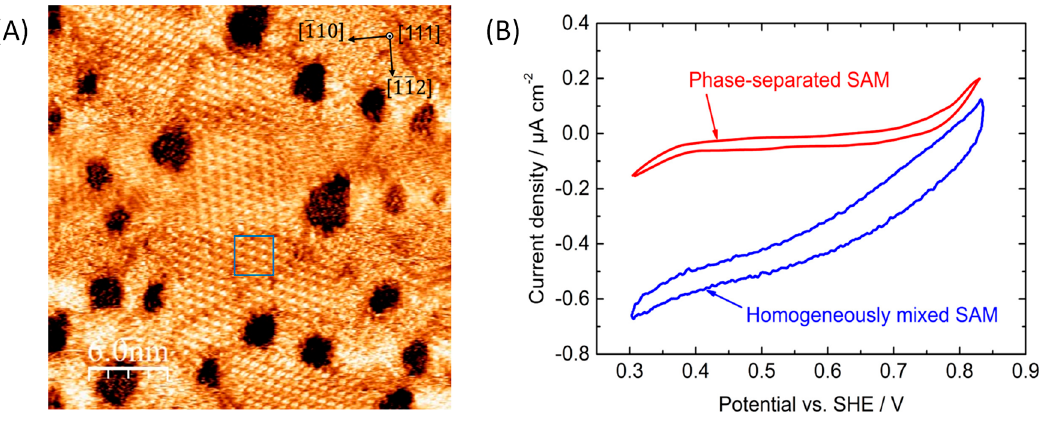
Figure 11. ( A ) EC-STM image showing homogeneous phase of a mixed SAM on Au(111) and ( B ) CVs of T. versicolor LAC immobilized on the homogeneously mixed SAM (blue) and the phase-separated SAM (red) on Au(111) in oxygen-saturated solution [153].